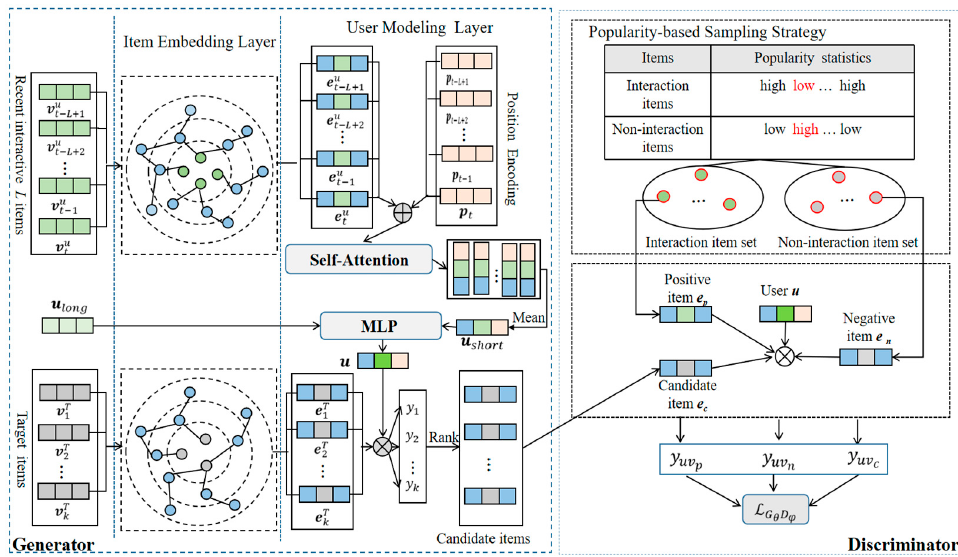
Figure 1. Illustration of the proposed ATKGRM model